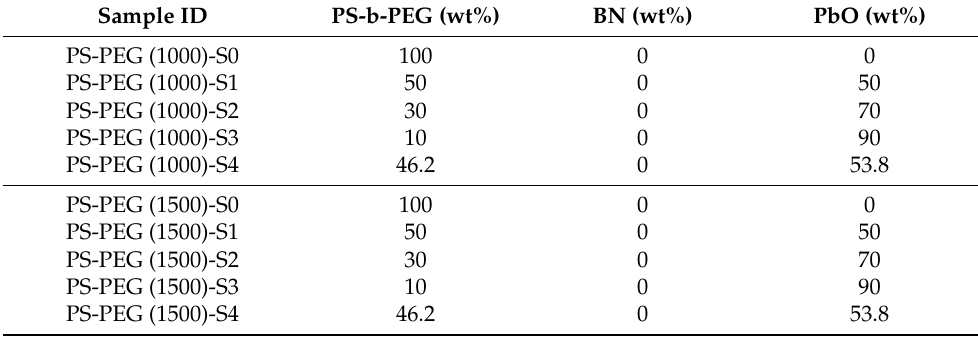
Table 1. Sample ID and compositions (by weight %) of the investigated